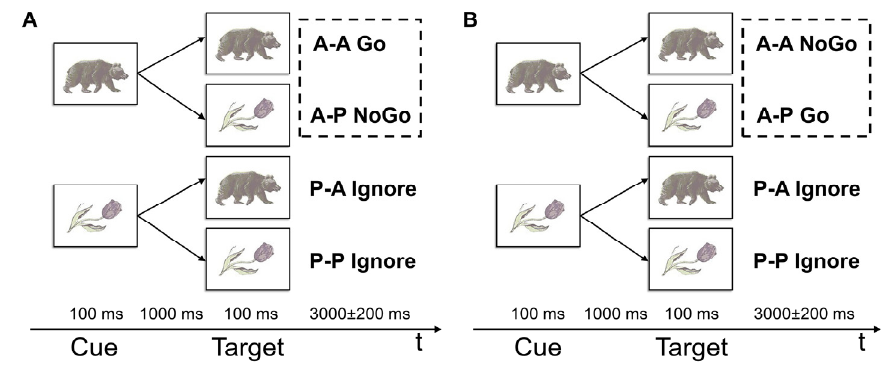
Figure 1. Task design. S1—the first stimulus (preparatory cue). S2—the second stimulus (target). A—images of animals, P—images of plants. ( А ) The first instruction: “A ‐ A Go”, “A ‐ P NoGo”. ( B ) The second instruction: “A ‐ P Go”, “A ‐ A NoGo”. Dashed boxes highlight trials that were compared second instruction: “A-P Go”, “A-A NoGo”. Dashed boxes highlight trials that were compared to to test the hypothesis on non ‐ selective response inhibition. test the hypothesis on non-selective response